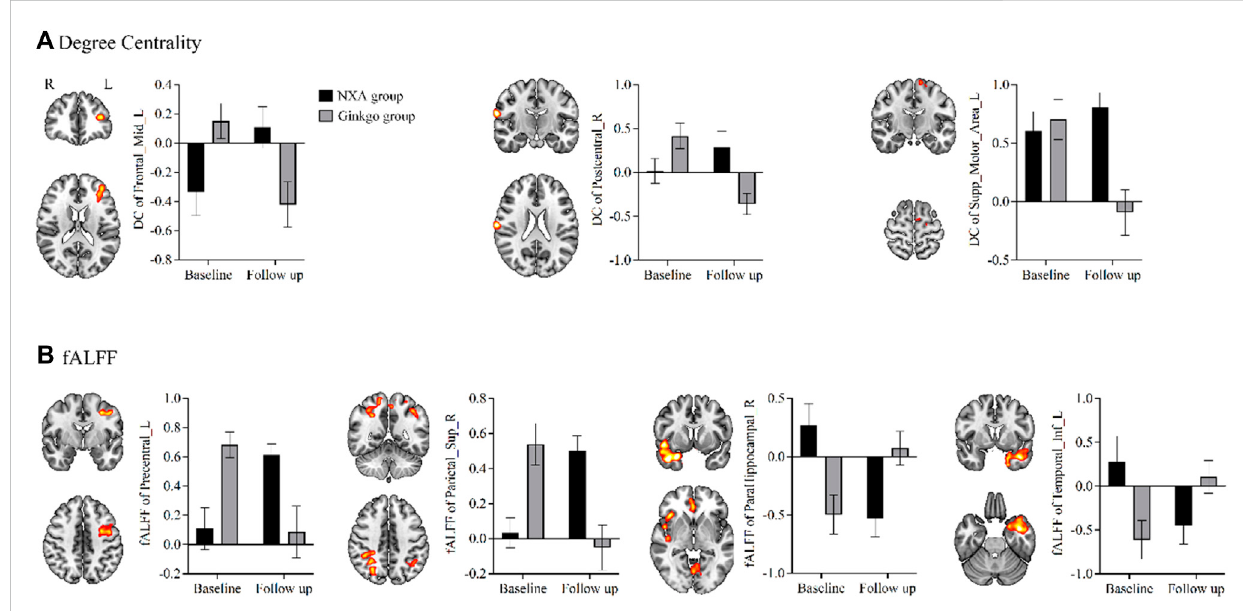
FIGURE 3 Control of brain function index in regions with signi fi cant pre- and post-treatment interaction between NXA group and ginkgo group. (A) Effects of the NXA capsule and ginkgo capsule on degree centrality. (B) Effects of the NXA capsule and ginkgo capsule on fALFF. Abbreviation: fALFF = fractional amplitude of low-frequency fl uctuations, L = left, R =